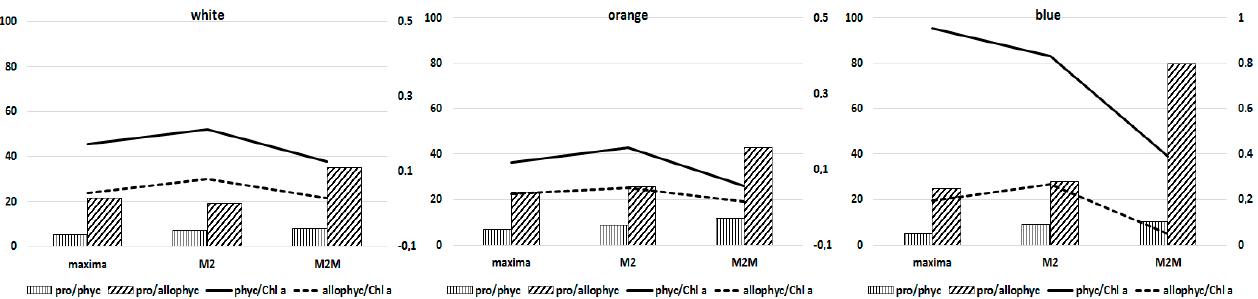
Figure 5. The ratio of protein/phycobilins, and phycobilins/Chl a , following exposure to white, orange and blue lights.